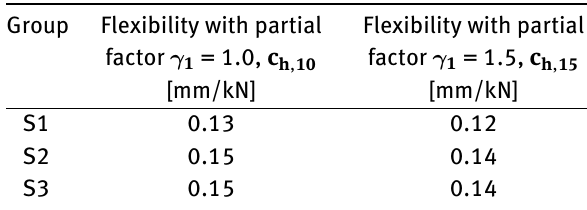
Figure 5: Method of prediction e k (displacement corresponding to the characteristic value of resistance R k ) and e u (ductility of connections).